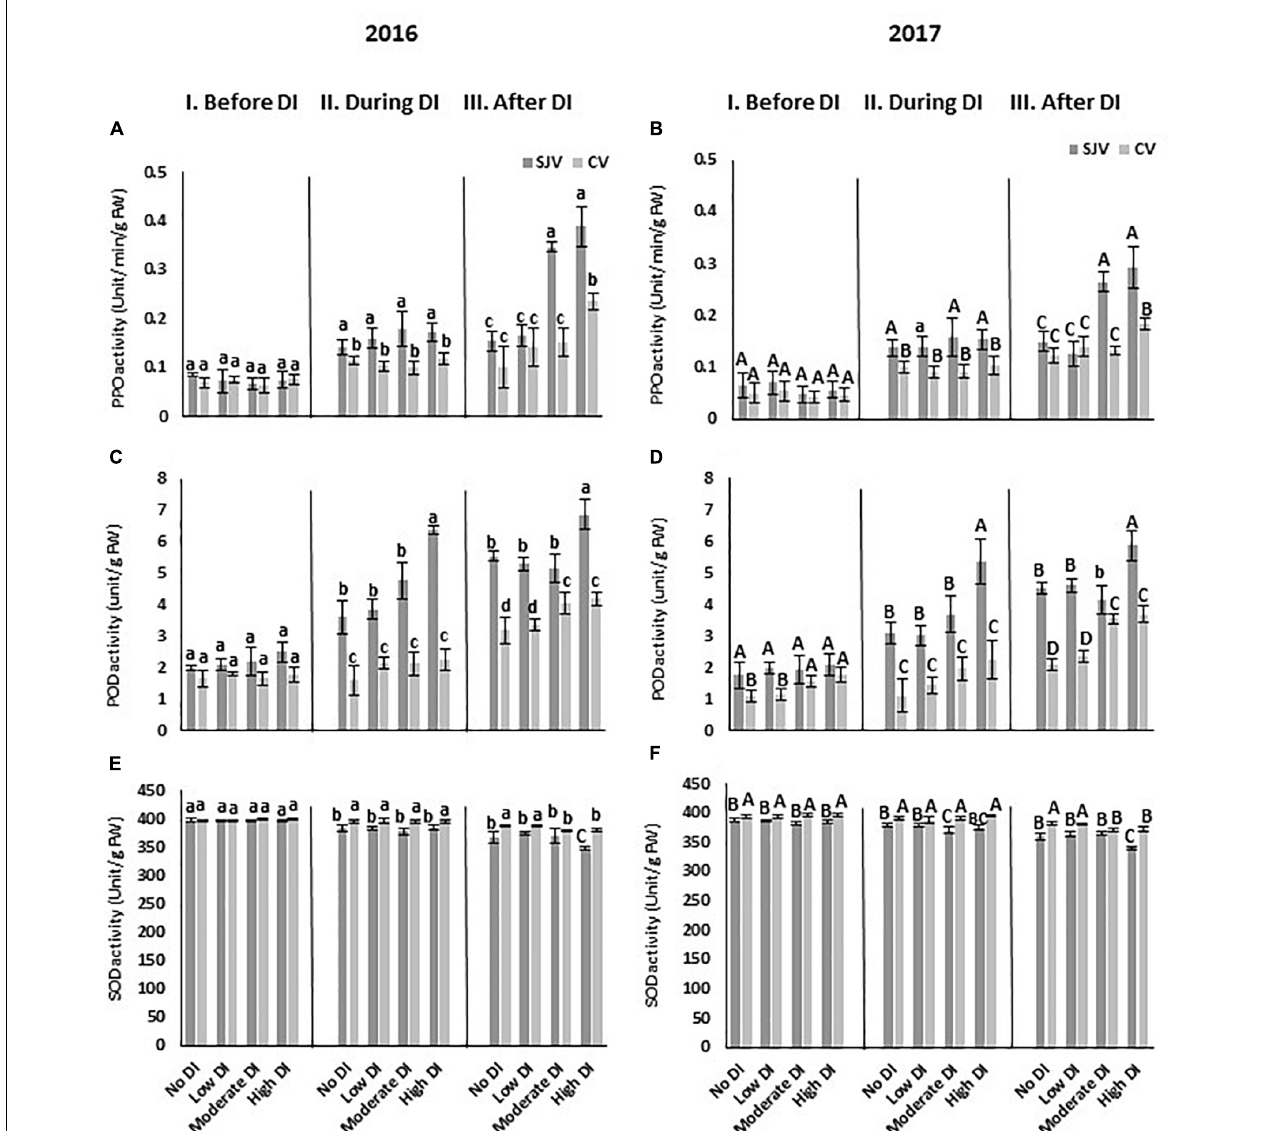
FIGURE 9 | Antioxidant enzymes activity in Scarlet Royal berry skin as affected by deficit irrigation (DI) treatments in 2016 and 2017 in San Joaquin (SJV) and Coachella (CV) Valleys. Enzymes involved in the antioxidant system are: polyphenol oxidase (PPO) (A,B) , peroxidase (POD) (C,D) , and superoxide dismutase (SOD) (E,F) . Enzyme activity was measured before deficit (I. Before DI), during deficit (II. During DI) and after re-irrigating vines with the original schedule (III. After DI). The error bars represent the standard deviation. Different letters on bars indicate significant differences among treatments and locations at p < 0.05 according to the Tukey HSD test within the same season. Different lower-case letters indicate a significant difference among treatments and locations in 2016 while capital letters are used for